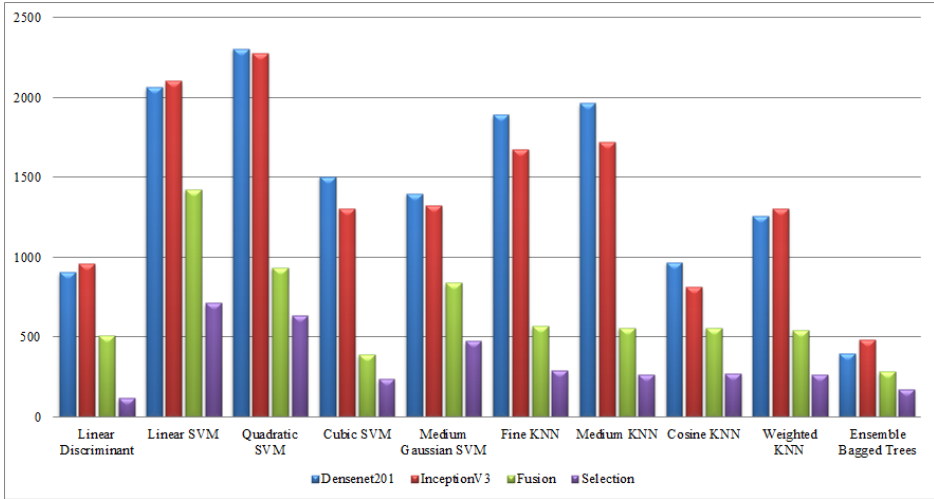
Figure 19. Computational time-based comparison of middle steps on IXMAS dataset.